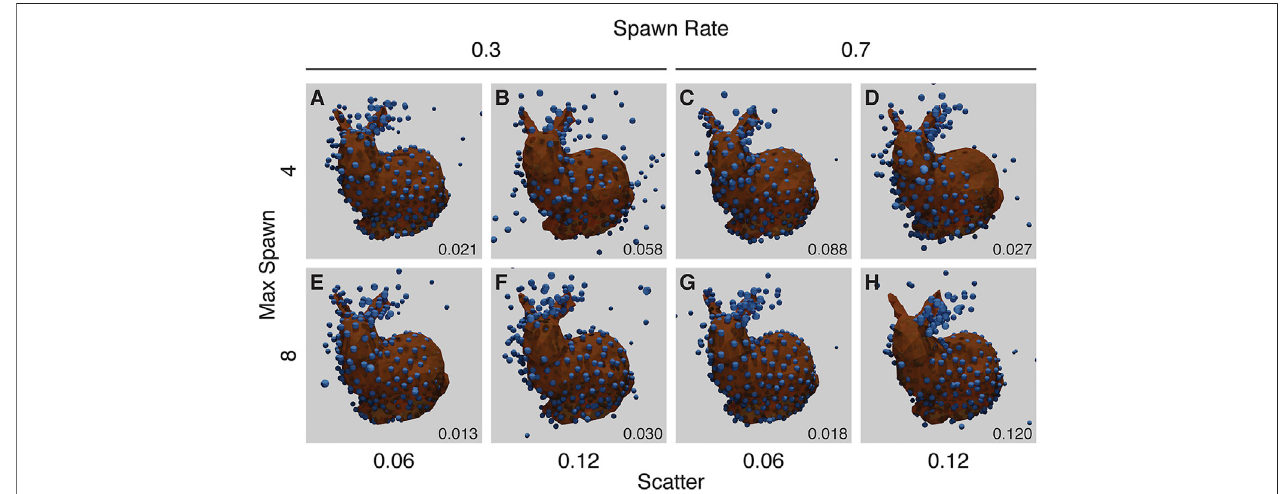
FIGURE 9 | Results from the Noise Experiment for each run (A – H) , with resulting RMSD shown in the lower right corner of each panel. The ground truth model is shown in orange, with the created structure shown as blue spheres, overlaid and aligned. The top row (A – D) shows runs with a maximum number of fl urophores per ground-truth point of 4, while the bottom row (E – H) shows runs with a maximum of 8. The left two columns (A, B, E, F) have a spawn-rate of 0.3, with the right two columns (C, D, G, H) have a spawn-rate of 0.7. Runs in (A, C, D, E, F, G) have incorrect symmetry whereas the run in (H) has mirroring in a vertical plane. The parameters for this experiment can be found in Supplementary Table S5.6